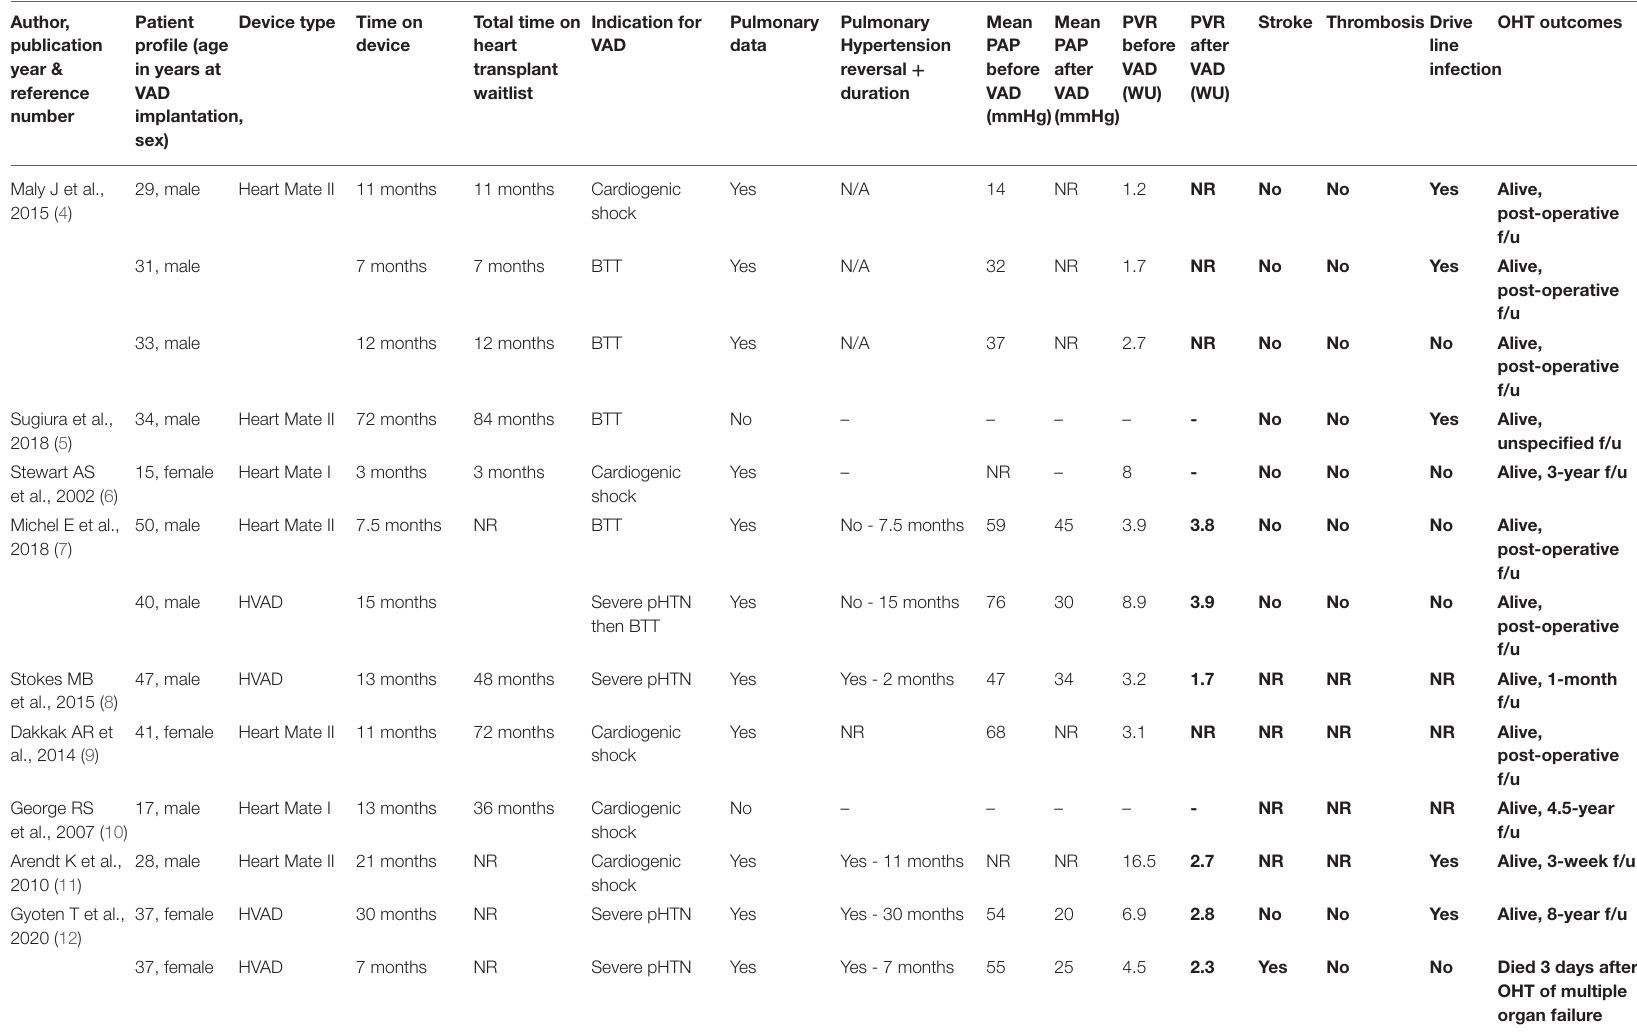
TABLE 2 | Summary of articles describing systemic CF-VAD implantation for RV failure in patients with prior history of atrial switch as a bridge to a successful heart